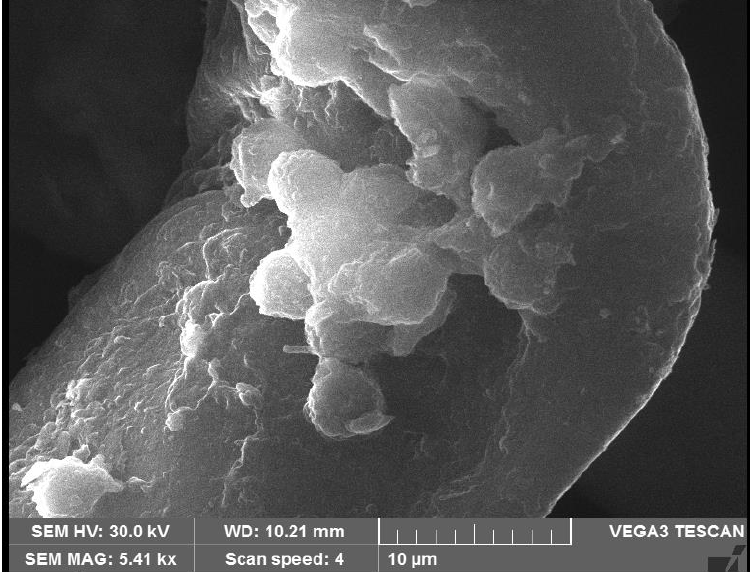
Figure 8. Scanning electron micrograph showing the synthesized AgNPs coated to the organic phase, viewed at 10 µm resolution, with a size of 40 nm at a magnification of 5400×.